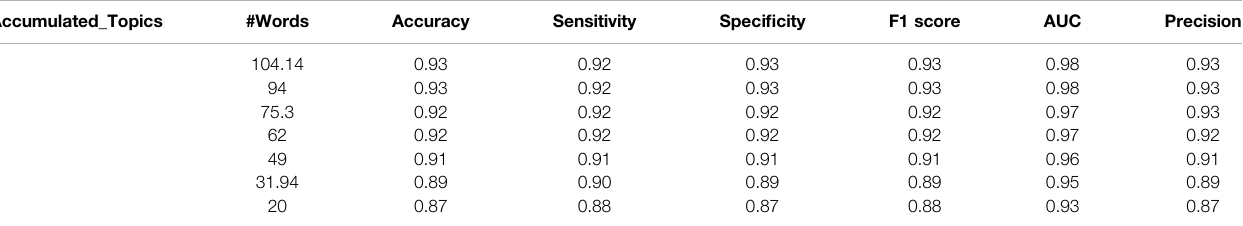
TABLE 4 | TextNetTopics performance over top topics for CAMDA dataset. #Accumulated_Topics column is the number of signi fi cant topics, #Words is the average of words on each level over the 100 iterations.